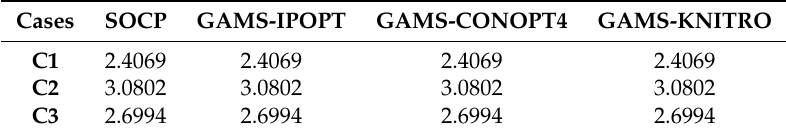
Table 3. Numerical results for the λ -coefficient for all the simulation cases in the 33-nodes test